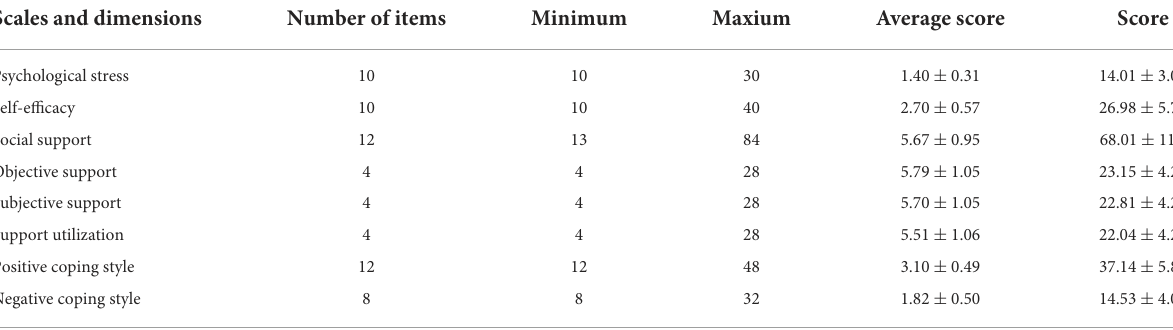
TABLE 2 The scores of psychological stress, self-efficacy, social support and coping